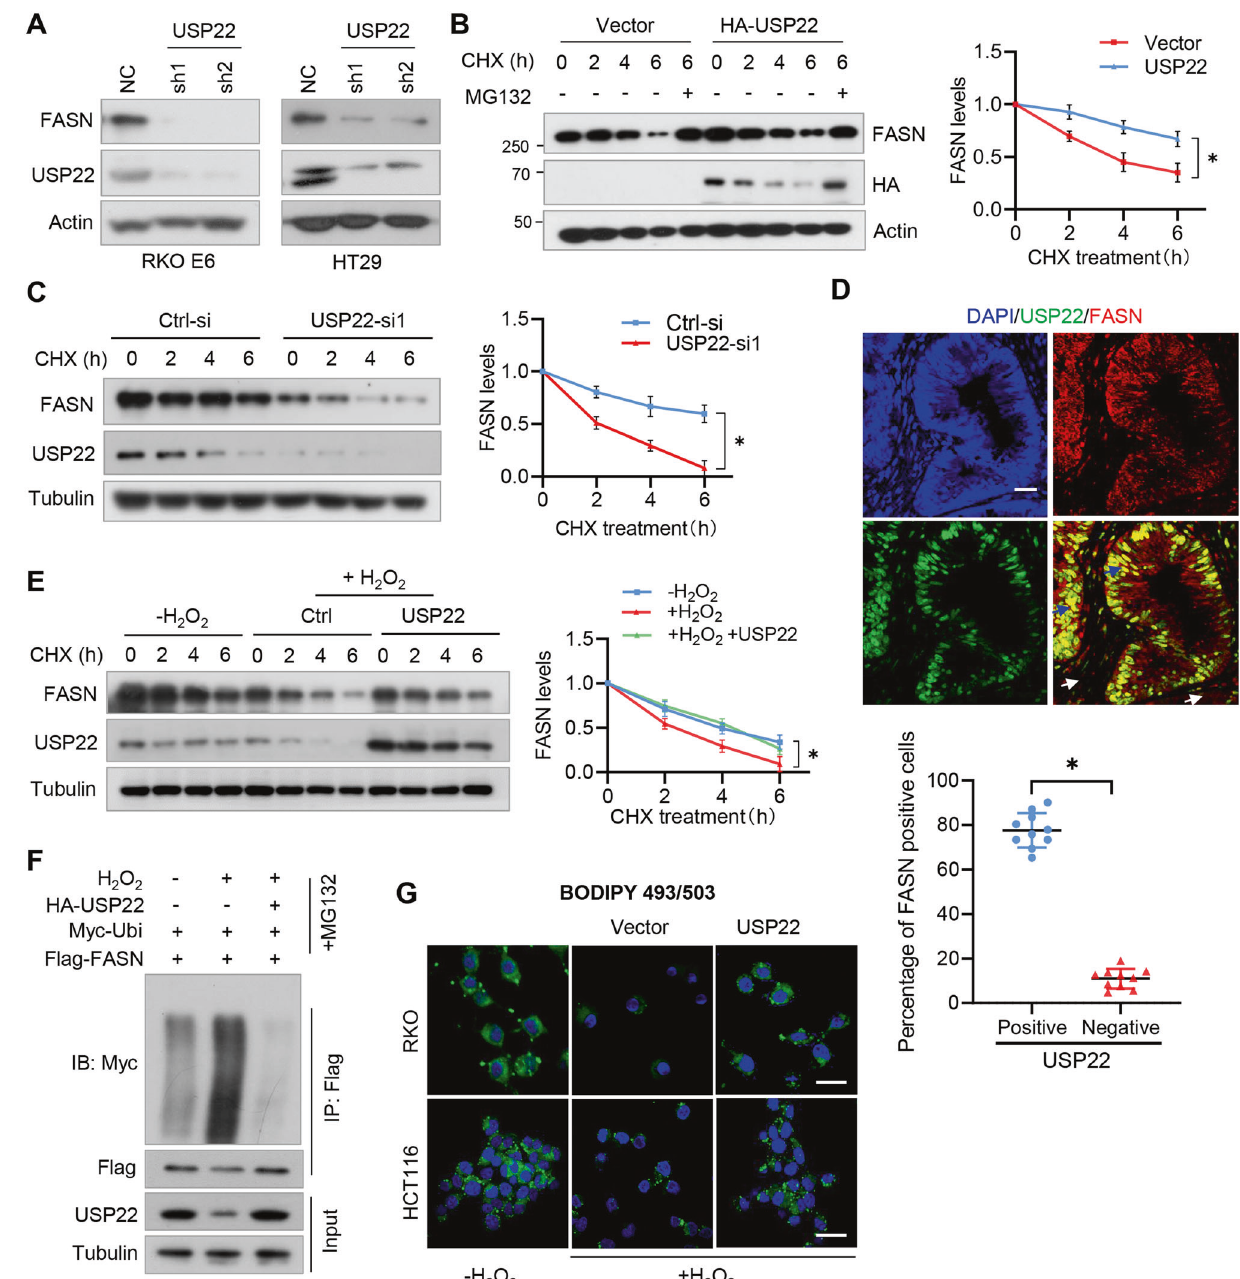
Fig. 3 H 2 O 2 destabilizes FASN and represses lipid synthesis through USP22 in p53 + / + CRC cells. A RKO E6 and HT29 cells expressing USP22 shRNAs were lysed and then subjected to immunoblotting using FASN and USP22 antibodies. B 293T cells were transfected HA-USP22 or a control vector, and then treated with CHX and MG132 as indicated. Cell lysates were analyzed by immunoblotting. C RKO E6 cells expressing USP22 shRNA were treated with CHX for the indicated time intervals. Cell lysates were analyzed by immunoblotting. D CRC tissues were double-stained with anti-USP22 and anti-FASN antibodies. Representative images are shown. The blue and white arrows indicate USP22/FASN double positive and double negative areas, respectively. Scale bars, 100 µm. In 10 randomly selected microscope fi elds of the tumor tissues, the percentages of USP22/FASN double-stained cells and USP22-negative but FASN-positive cells were analyzed and compared (mean ± s.e.m., unpaired Student ’ s t-test). E RKO cells were transfected with HA-USP22 and then treated with CHX for the indicated time intervals in the presence of H 2 O 2 or not. Cell lysates were analyzed by immunoblotting. In B , C , and E , band intensities of FASN were quanti fi ed and the results are expressed as FASN levels relative to the control cells (mean ± s.d., n = 3 independent experiments, paired Student ’ s t-test, right panels). ∗ P < 0.01. F 293T cells were transfected with HA-USP22, Myc-Ubi, and Flag-FASN, and then treated with H 2 O 2. Cell lysates were immunoprecipitated using an anti-Flag antibody and then analyzed by immunoblotting. G RKO and HCT116 cells expressing USP22 were treated with H 2 O 2 for 24 h. Cellular lipid droplets were visualized fl uorescently with Bodipy 493/503. Representative images are shown. Scale bar, 20 µm.